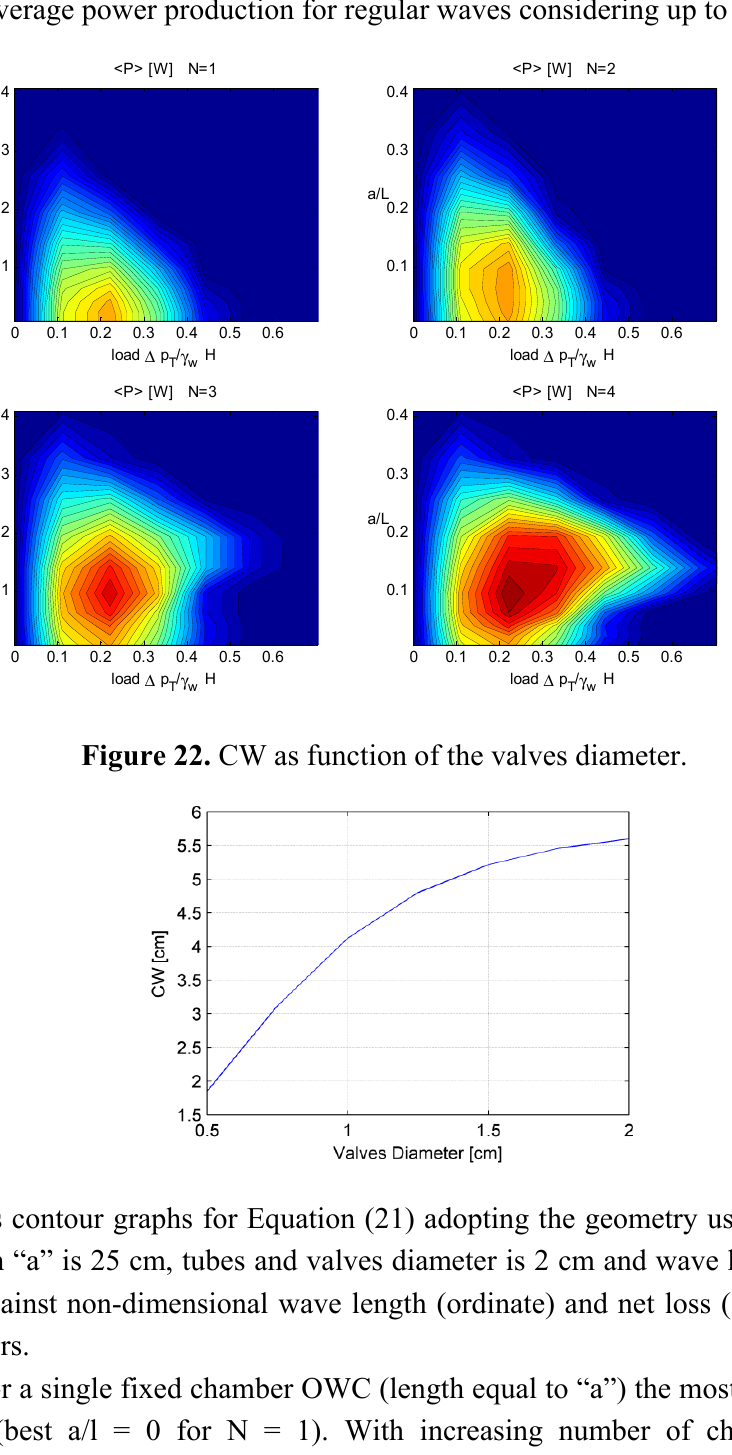
Figure 21. Average power production for regular waves considering up to N = 4 chambers.